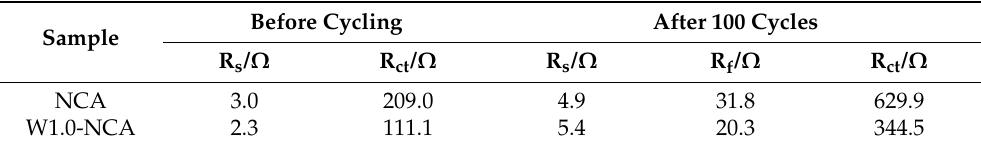
Figure 7. EIS and equivalent-circuit diagram of EIS curves fitting of NCA and W1.0-NCA during ( a ) before cycling and ( b ) after 100 cycles. Table 2. The fitted values of experimental data for NCA and W1.0-NCA.